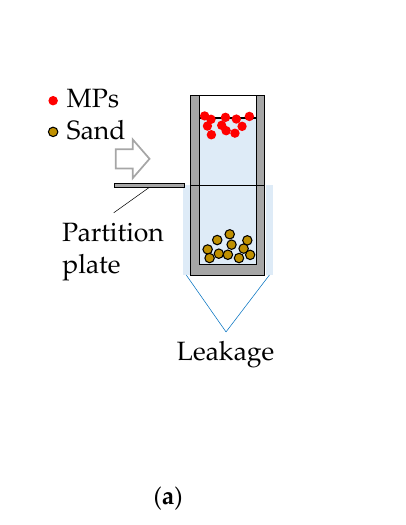
Figure 6. Insertion of partition plate to prevent remixing of floating matter and sinking matter: ( a ) insertion of partition plate in the gas phase causes water leakage; ( b ) method of Nakajima et al. (2019) [44].